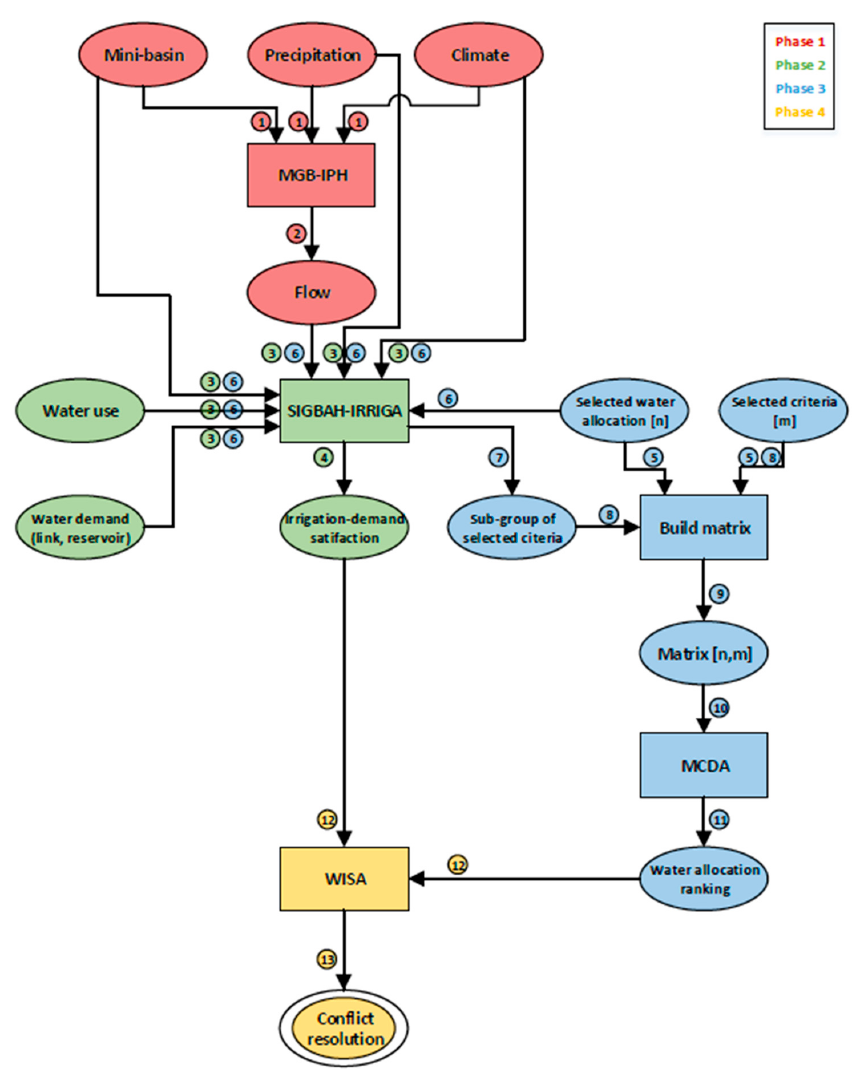
Figure 1. Conceptualization of the scenario-based framework for conflict resolution in water allocation. (Symbols used: A circle represents the input/output; a double circle symbolizes the output of the entire framework; a rectangle represents the process).